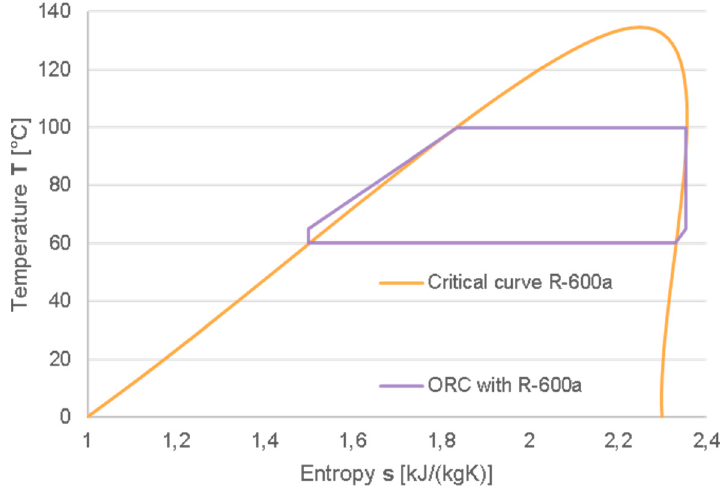
Figure 6. T-s diagram of isobutane (R-600a) used in a subcritical ORC as working medium [6,8].